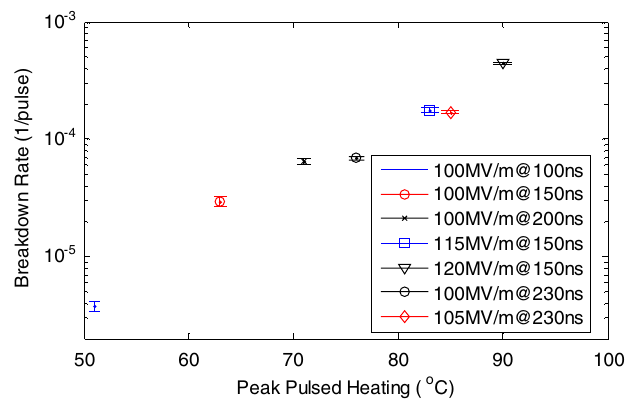
FIG. 8. The HOM-damped multicell X -band TW structure high-power test results.